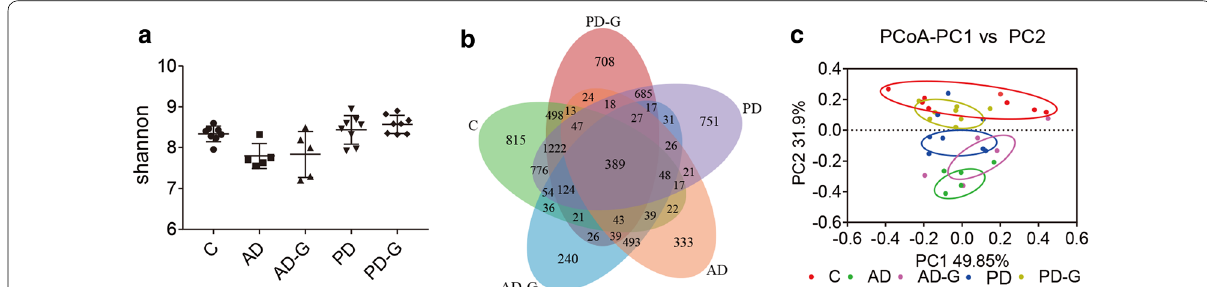
Fig. 4 Gut microbial dysbiosis in AD and PD mice was reduced by MG1363-pMG36e-GLP-1. a the shannon index. b Petal map representation of OTUs. c PCoA of β diversity index. C, control group (n MPTP group (n